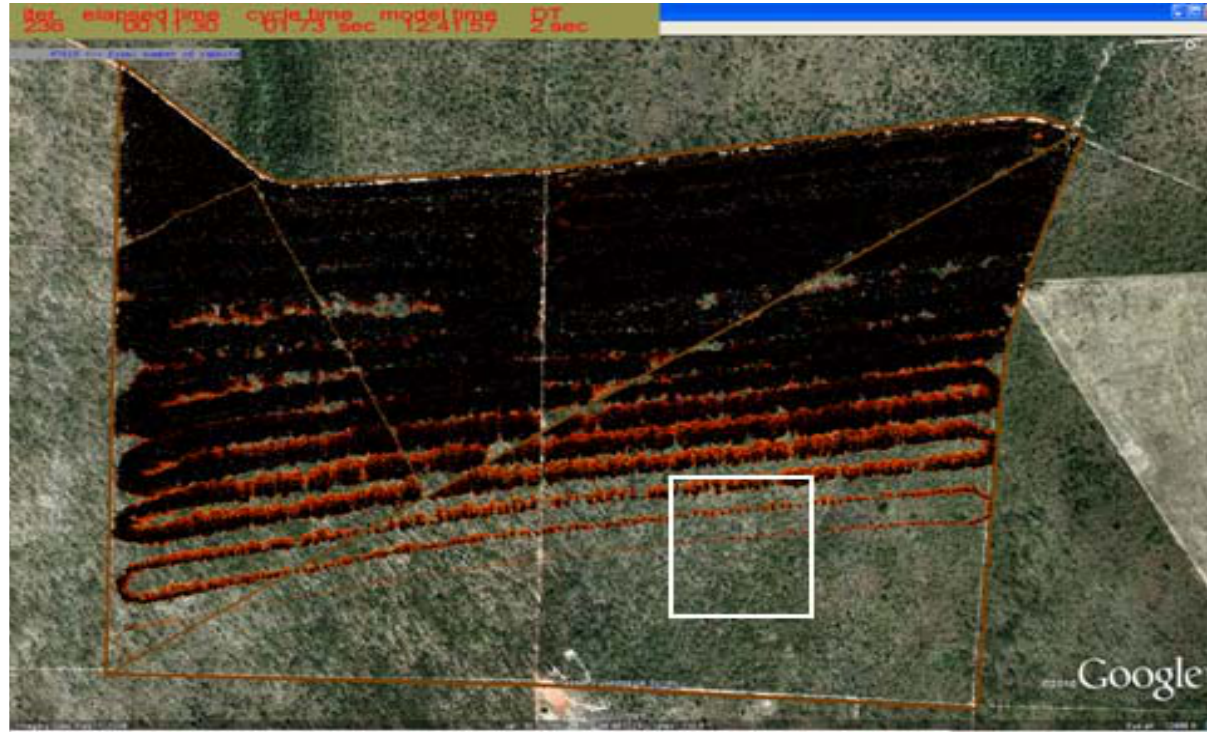
Figure 3. Progress of helicopter ignition and burn-out for 12:41:57 6 February